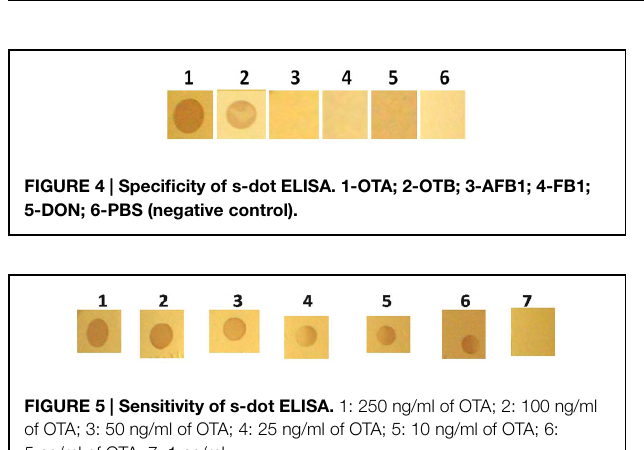
FIGURE 3 | Specificity of anti-OTA mAb. (A) Indirect plate ELISA, (B) dot ELISA. ∗ P ≤ 0.05.